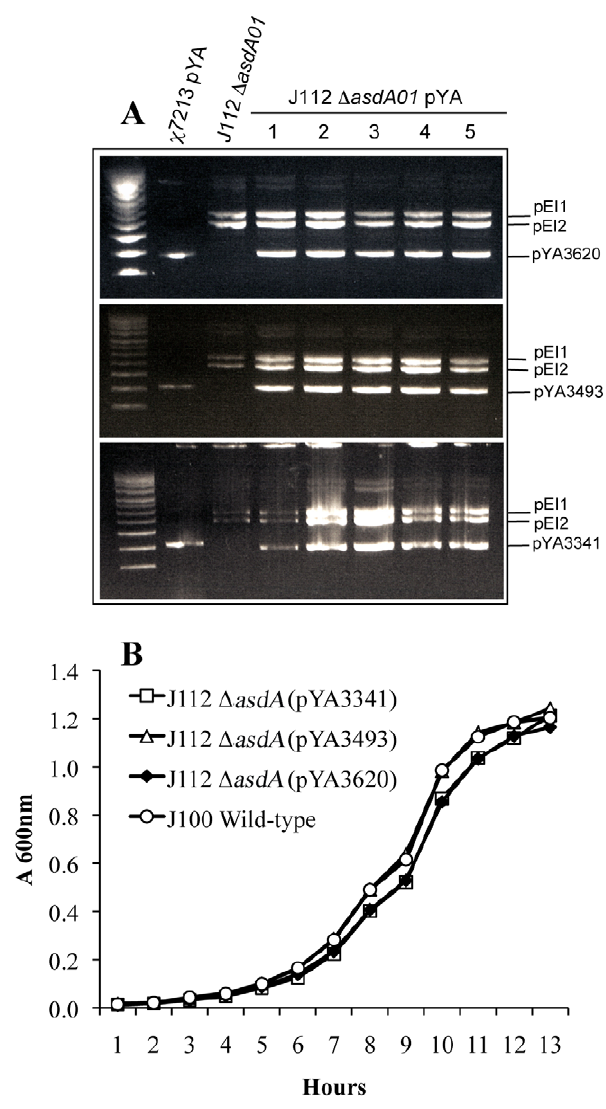
Figure 7. Complementation of asdA gene with Asd + vectors. ( A ) Plasmid profile of E. ictaluri D asdA01 complemented with AsdA + vectors of different copy number. pEI1 (5.7 kb), pEI2 (4.9 kb), pYA3620 (3169 bp), pYA3493 (3113 bp), pYA3341 (2595 bp); Supercoiling ladder, from the top to the bottom: 16210 bp, 14174 bp, 12138 bp, 10102 bp, 8066 bp, 7045 bp, 6030 bp, 5012 bp, 3990 bp, 2972, 2067 bp; ( B ) Growth of E. ictaluri D asdA01 complemented with different AsdA + vectors; The strains were grown in BHI at 28 u C with agitation (180 r.p.m.).